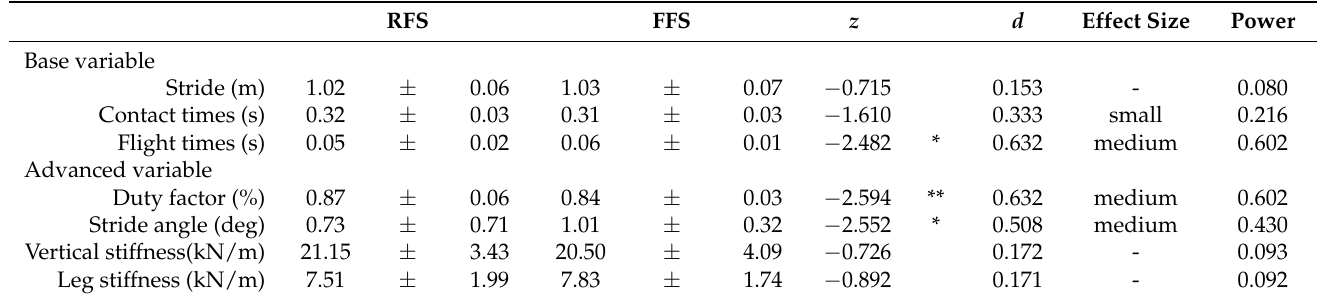
Table 2. Male running base and advanced variable parameters. (Mean ± SD) ( N = 15).